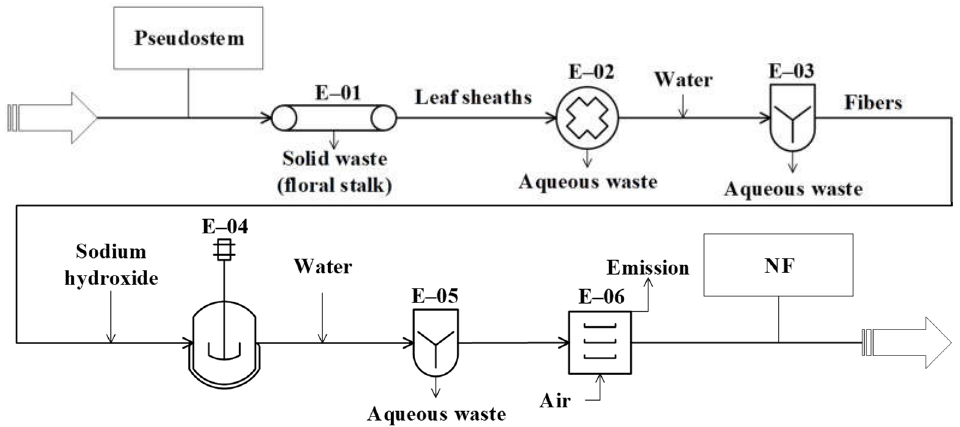
Figure 2. Diagram of the conceptual design for producing natural fibers (NFs) from pseudostems.